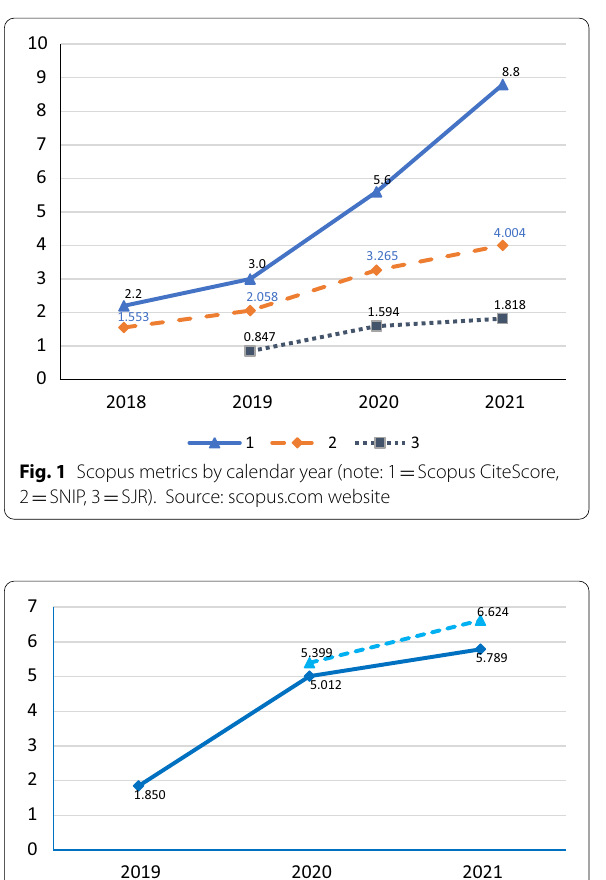
Fig. 2 Clarivate’s IF by calendar year (1 Source: Clarivate’s journal citation